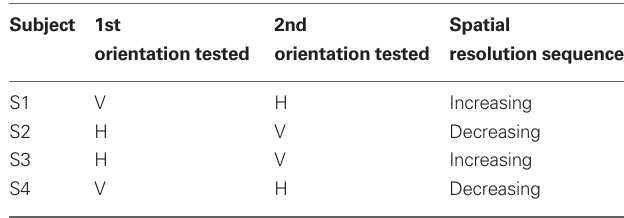
Table 1 | Order of testing conditions for each